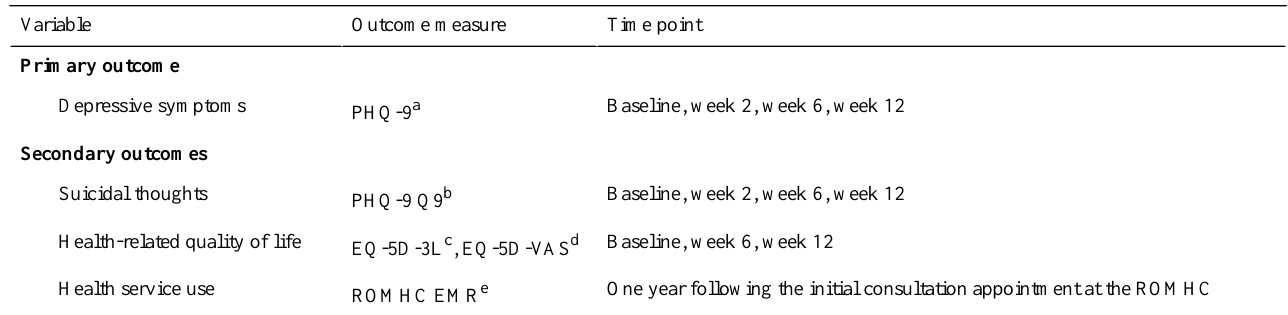
Table 2. Outcome measures and timing of